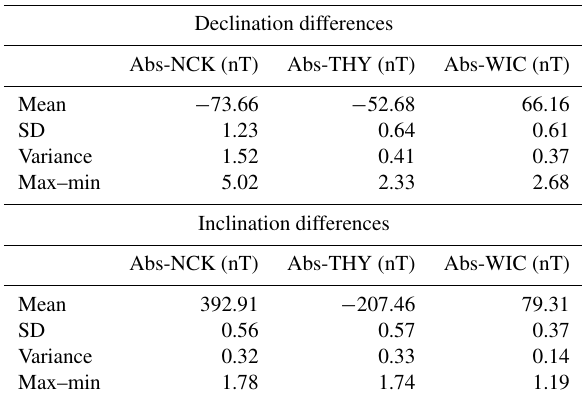
Table 1. The statistical parameters of the differences between abso- lute and variometer declination/inclination